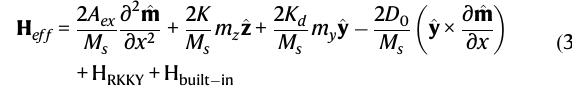
of device with the same dimension as the experiments. d Time-dependent tem- peratureatthe center of device as highlighted in the white dashed circleof c .Inset illustrates the cross-section of temperature distribution pro fi le along the length of